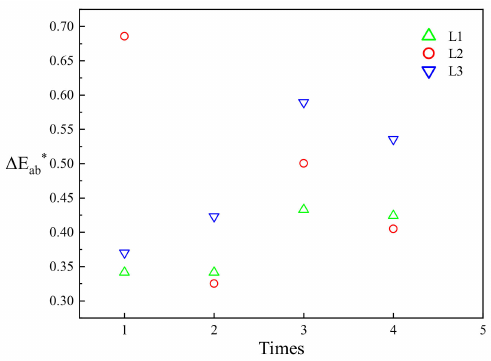
Figure 7. Color difference ( ∆ E ab * ) of calibration soil specimen under three light